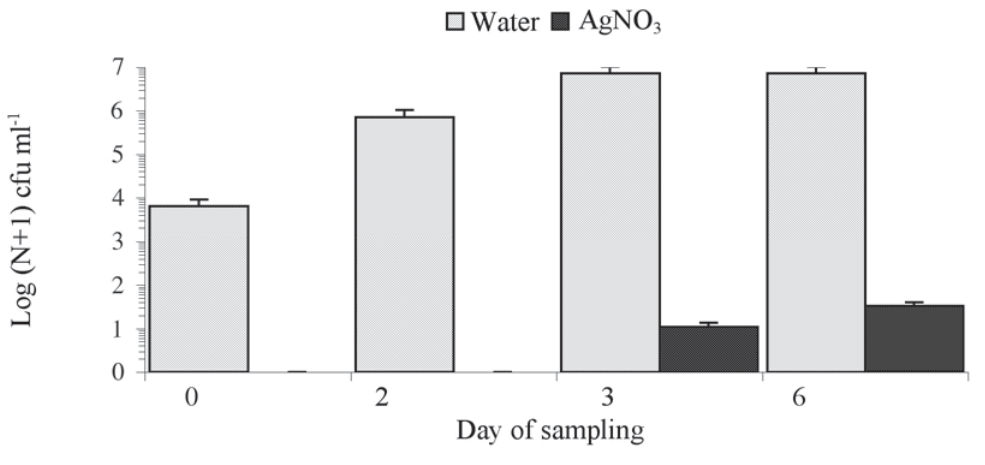
Fig. 3. Cumulative bacterial populations in tap water and AgNO